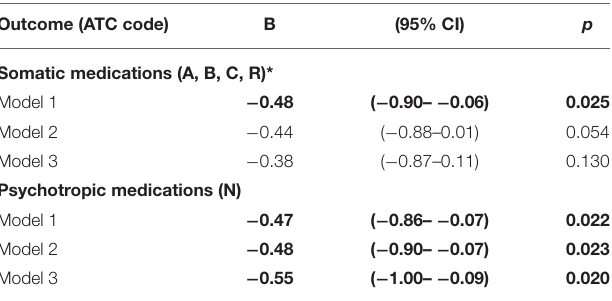
TABLE 3 | Linear regression estimating treatment effects of MULTI compared to treatment as usual on mean daily defined dose ( N = 114). Outcome (ATC code) B (95% CI) p Somatic medications (A, B, C,